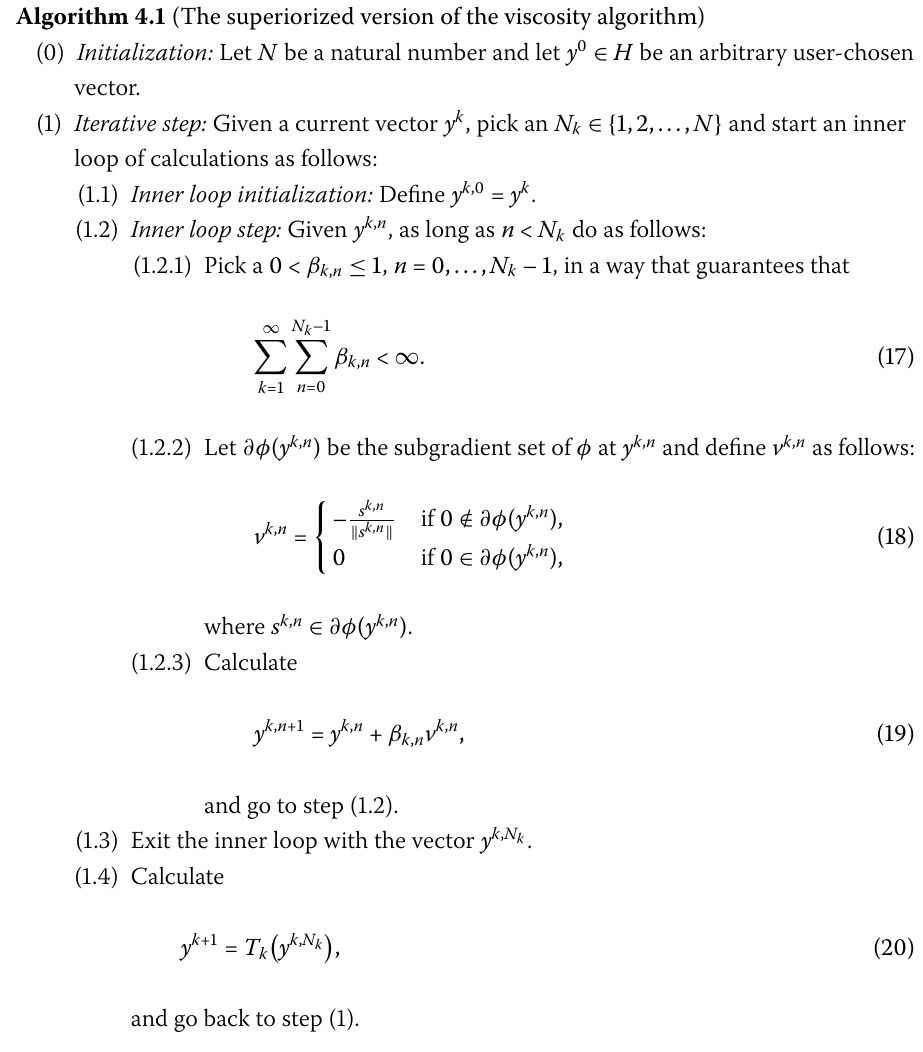
Algorithm . (The superiorized version of the viscosity